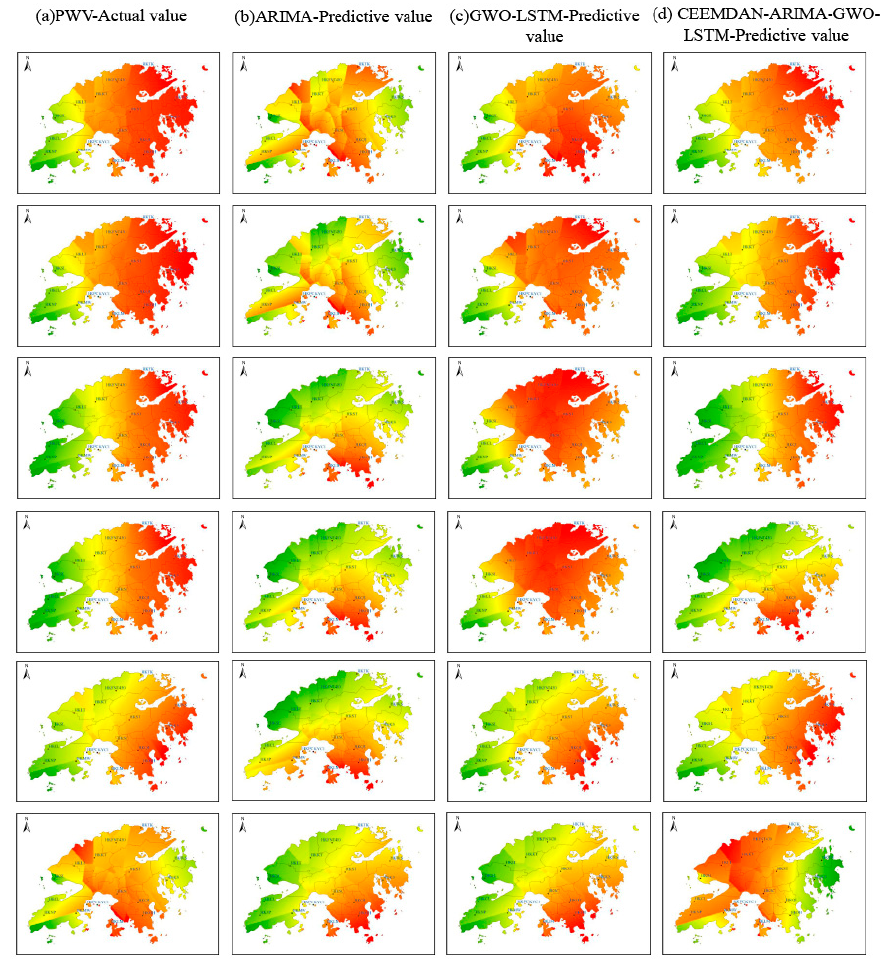
Figure 14. The results of the visual display of the numerical space visualization using kriging interpolation completed at 0:00, 4:00, 8:00, 12:00, 16:00, and 20:00 on July 31. Where ( a ) the original data is used, ( b ) the ARIMA model prediction results are used, ( c ) the GWO-LSTM model prediction results are used, ( d ) the combined model prediction results of this paper are